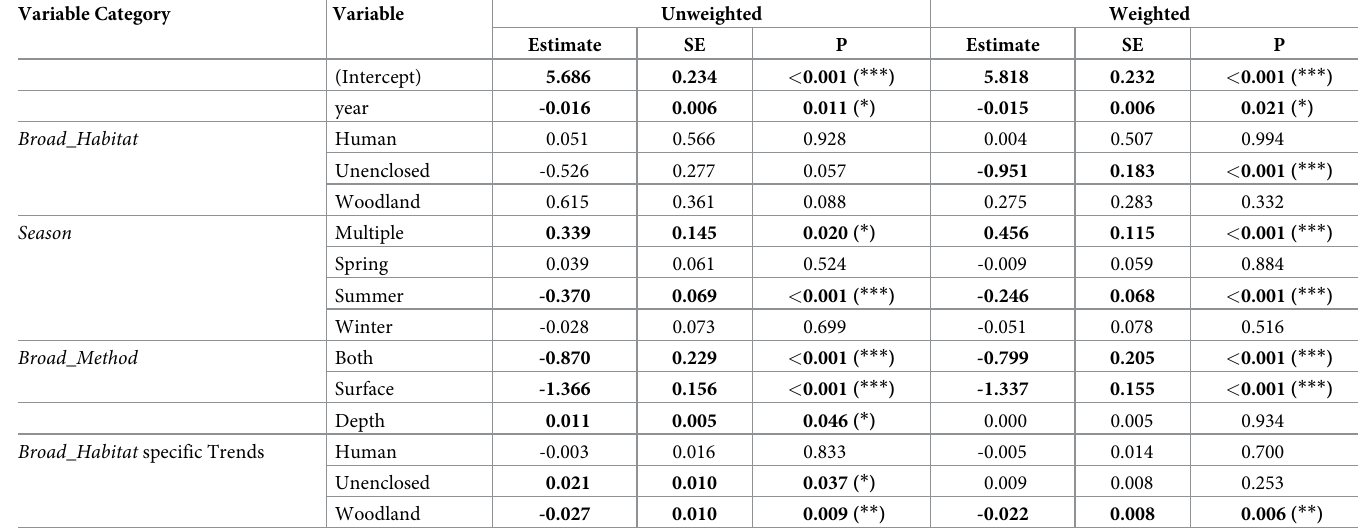
Table 5. Model 3 output of earthworm abundance trends. Unweighted and weighted (by the natural log of Sample Extent +1) Model 3 estimates with the interaction of Year with Broad_Habitat providing habitat specific trends compared to the base, farmland, trend shown in the year estimate (significant estimates are in bold, the stars rep-